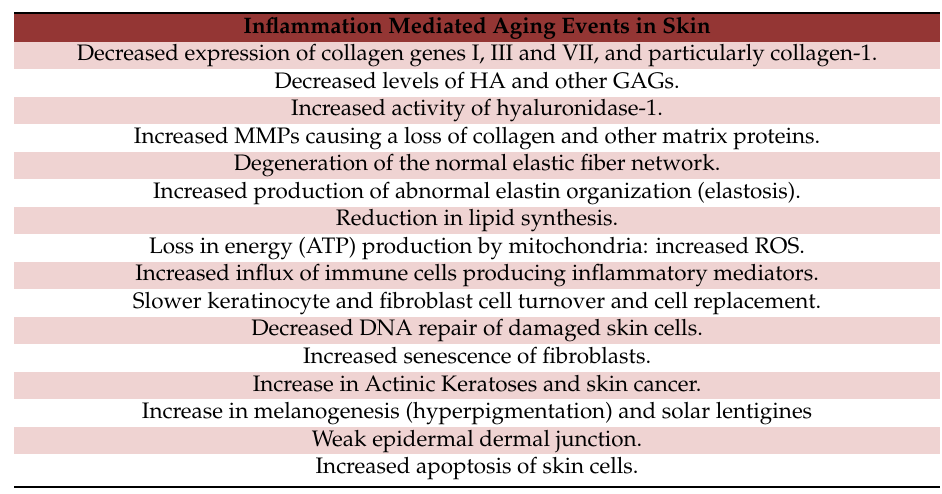
Table 1. A partial list of intrinsic and extrinsic aging events that occur in keratinocytes, fibroblasts, immune cells and melanocytes in response to inflammatory mediators produced in the